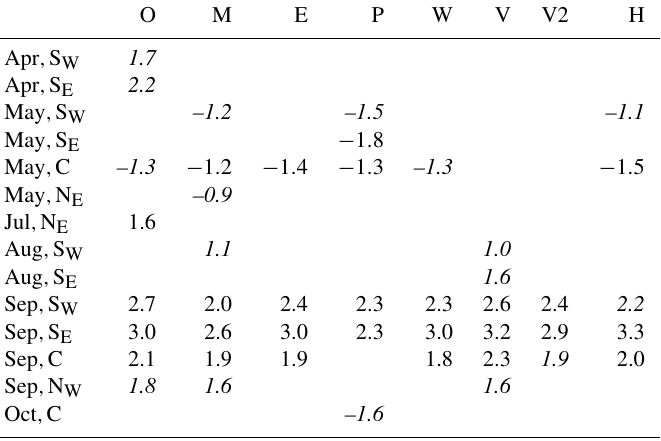
Table 6. Linear, decadal trends in monthly mean T d ( ◦ C) between 1985 and 1999, significant at a 5% or 10% (denoted in italics) level in the observations (O) and the model estimates, listed with the month and region denoted on the left (month, region). O